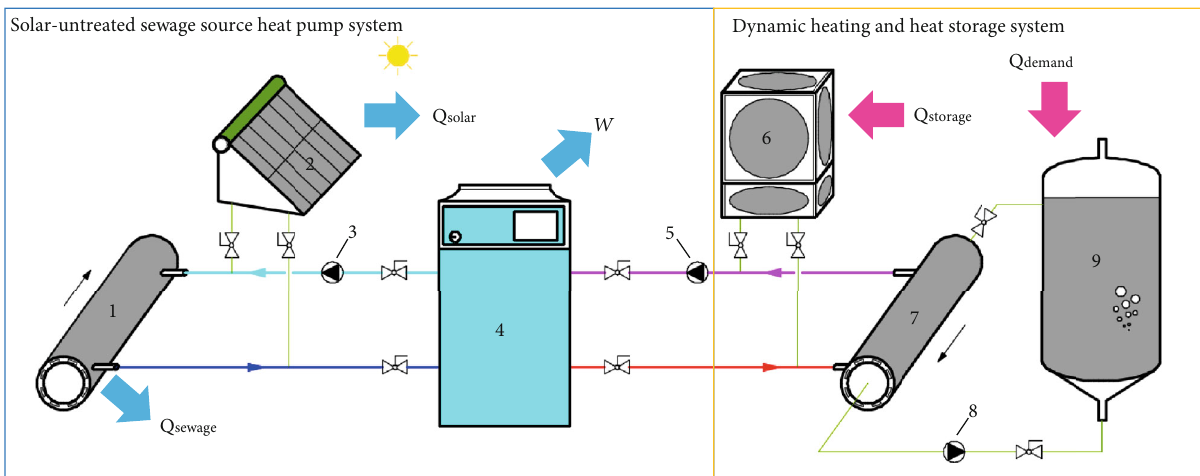
Figure 2: Schematic of the SUSSHPS and dynamic heating and heat storage system. 1 — sewage double-pipe heat exchanger; 2 — solar collector; 3 — chilled water pump; 4 — heat pump unit; 5 — cooling water pump; 6 — heat storage tank; 7 — slurry double-pipe heat exchanger; 8 — biogas slurry pump; 9 — MFD.